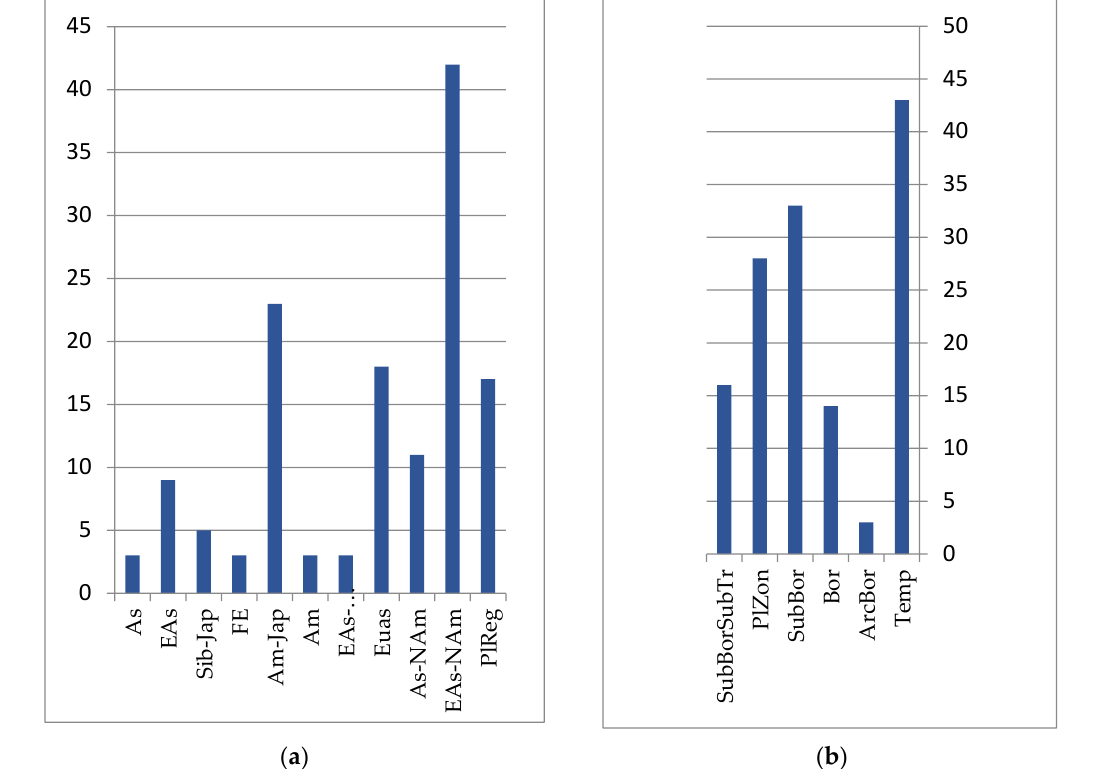
Figure 7. Number of species groups of the aquatic – semiaquatic floristics complex: ( a ) longitudinal species groups: Asian (As); Eastern Asian (EAs); Siberian – Far Eastern (Sib-FE); Far Eastern (FE); Amurense – Japanese (Am-Jap); Amurense (Am); Eastern Asian – Paleotropical (EAs-PalTrp); Eurasian (Eas); Asian – North American (EAs-Nam); Eurasian – North American (Eas-NAm); PlReg – pluriregional; ( b ) zonal species groups: temperate (Temp); arcto – boreal (ArcBor); boreal (Bor); sub-boreal (SubBor); plurizonal (PlZon); sub-boreal – sub-tropical (SubBorSubTrp).